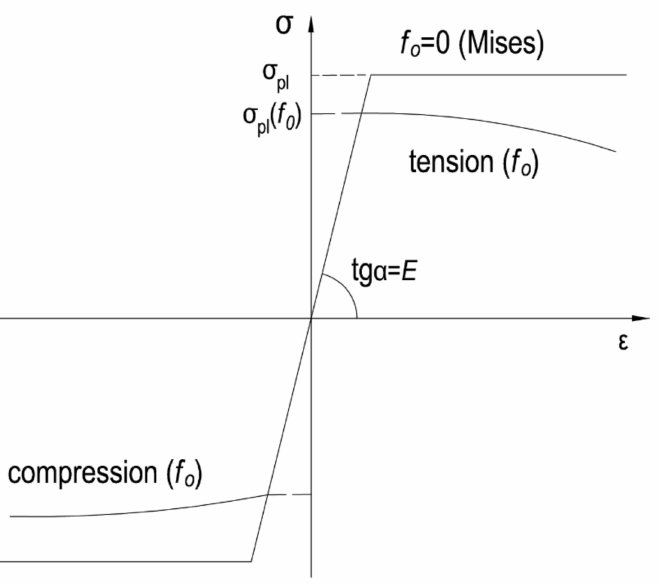
Figure 3. Schematic of uniaxial behavior of a porous metal (perfectly plastic matrix material with initial volume fraction of voids = f 0